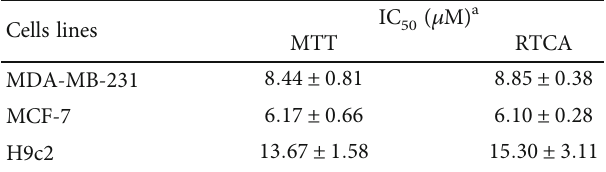
Table 2: IC of compound 3F1 at 24h (MTT assay versus RTCA). 50 Cells